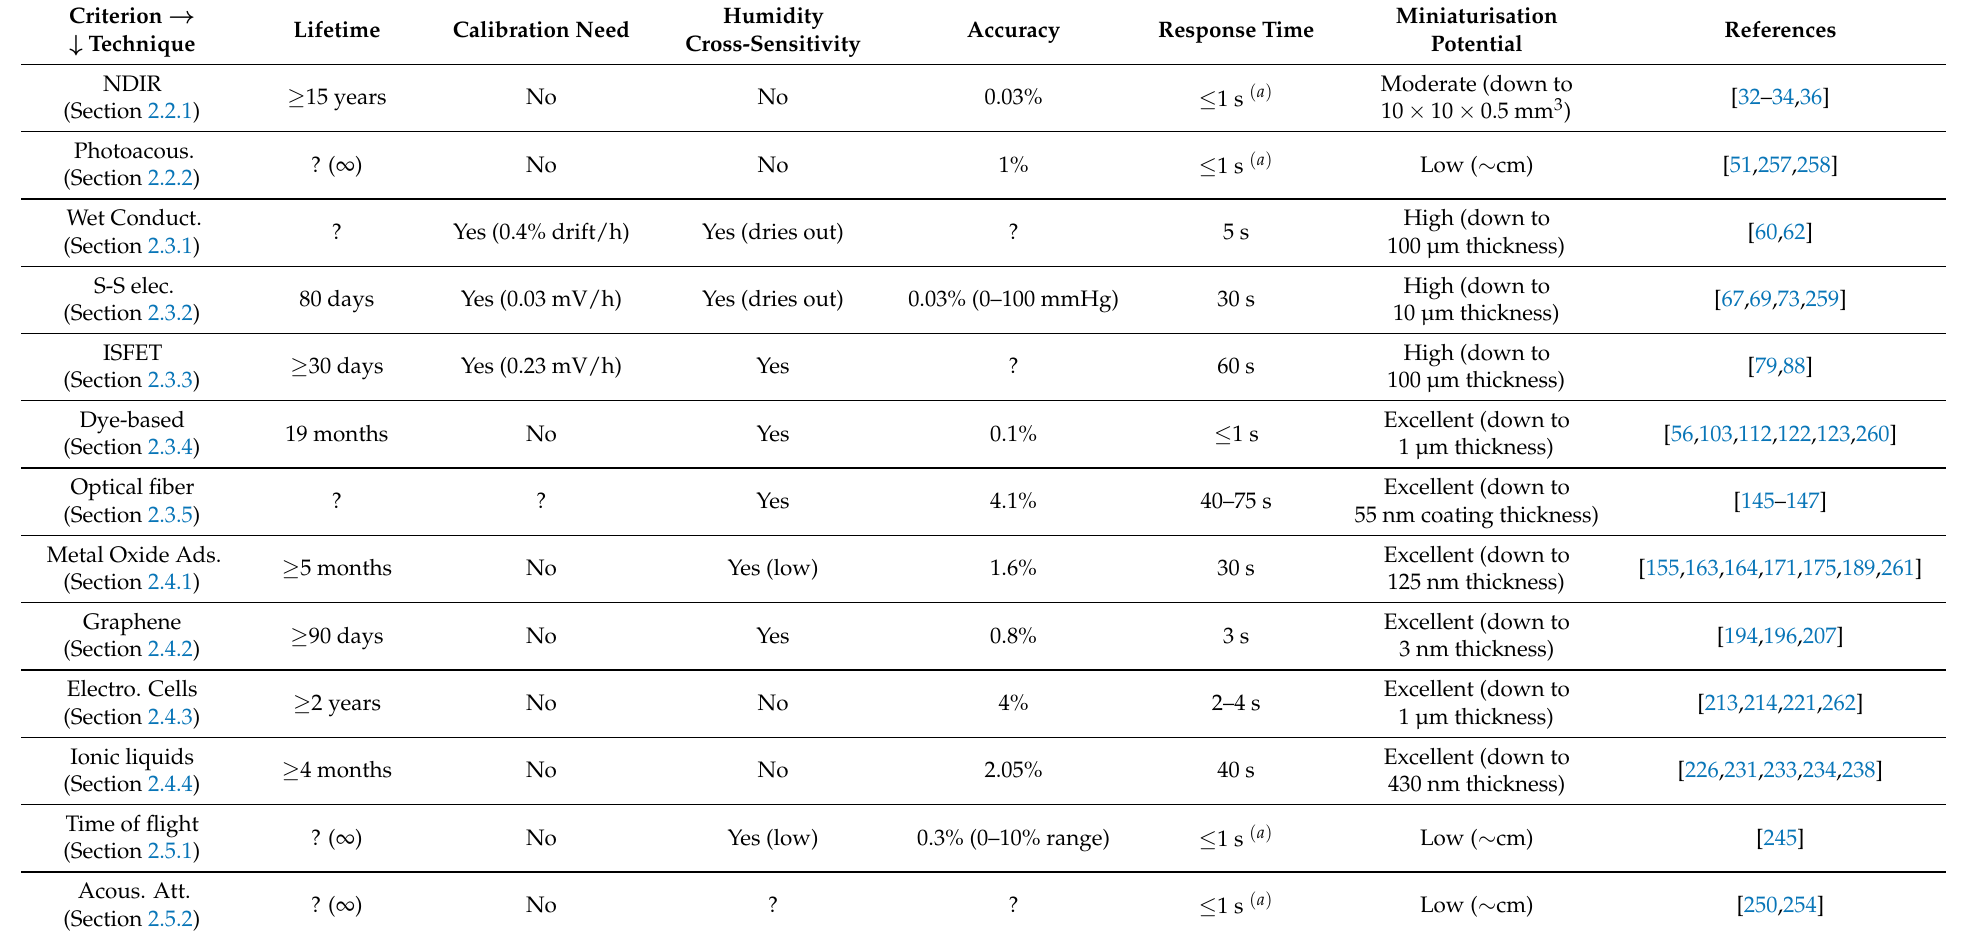
Table 1. An overview of the presented techniques. ( ∞ ): expected to be at least several years. ( a ) : limited primarily by the diffusion of the analyte gas inside the enclosure of the sensor. Please refer to detailed explanations in Section